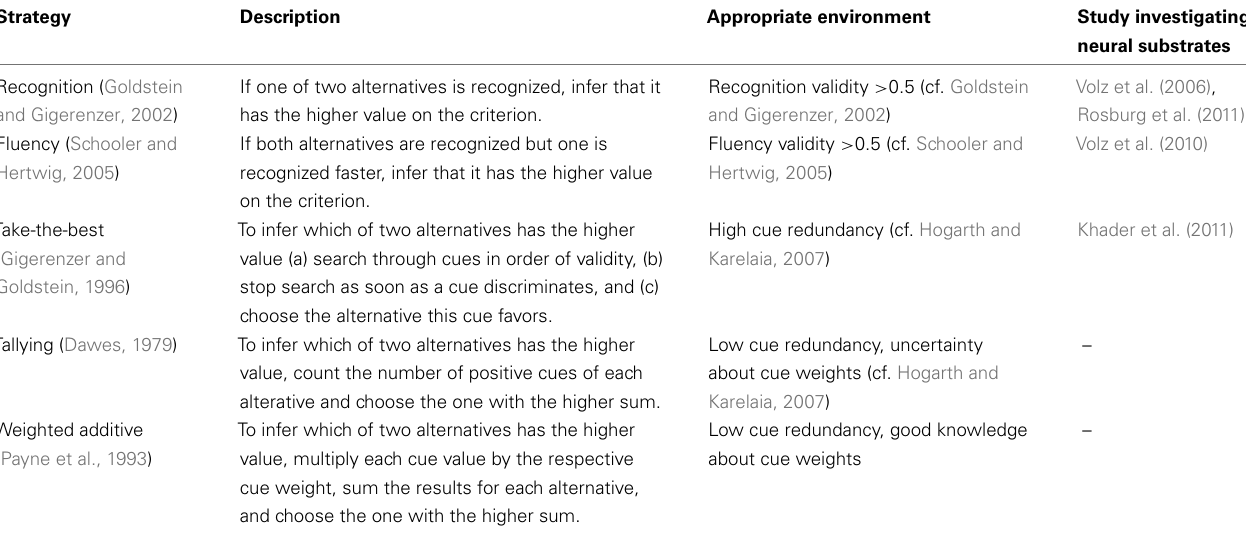
Table 1 | Decision strategies, respective ecologies, and studies investigating their neural substrates.